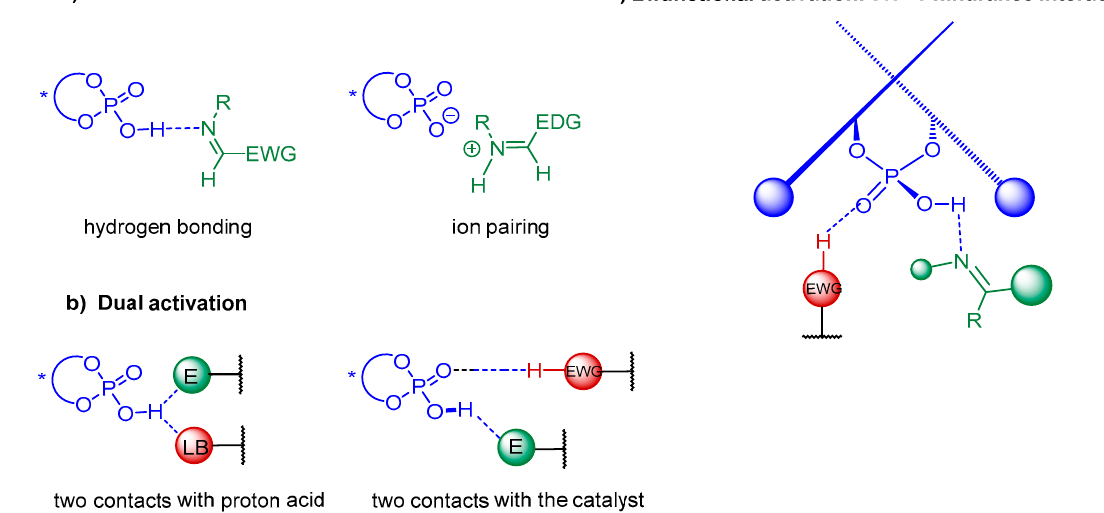
Figure 6. Activation modes of substrates by phosphoric acids.